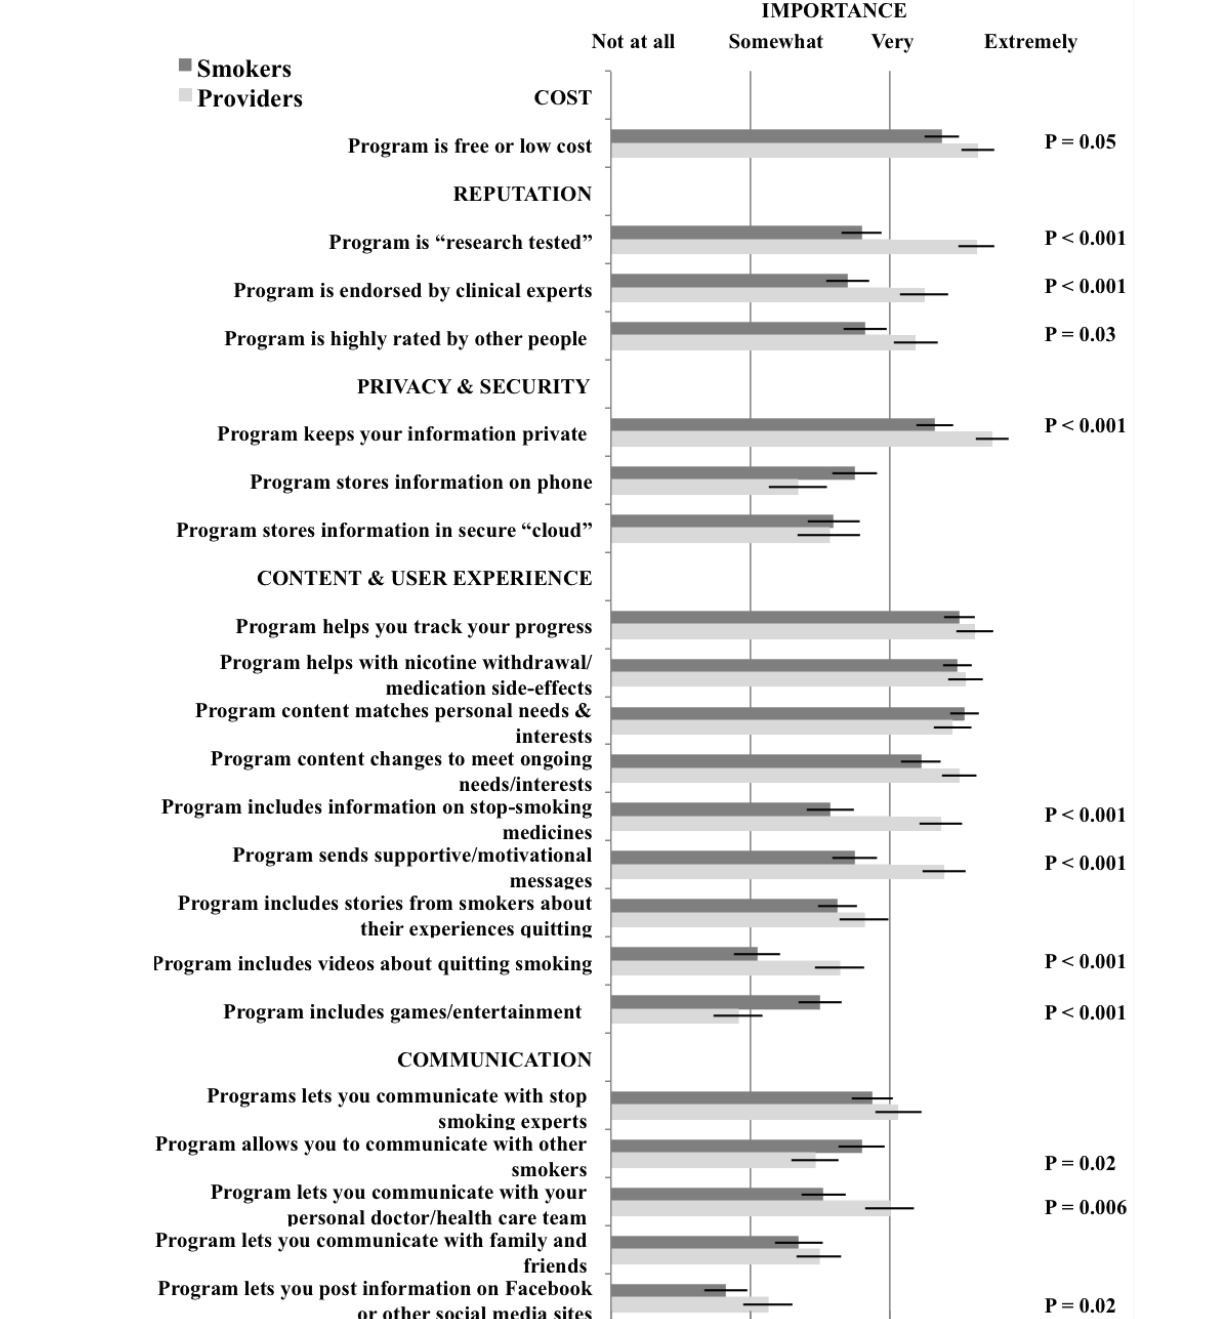
Figure 1. Comparison of providers' and smokers' ratings of important